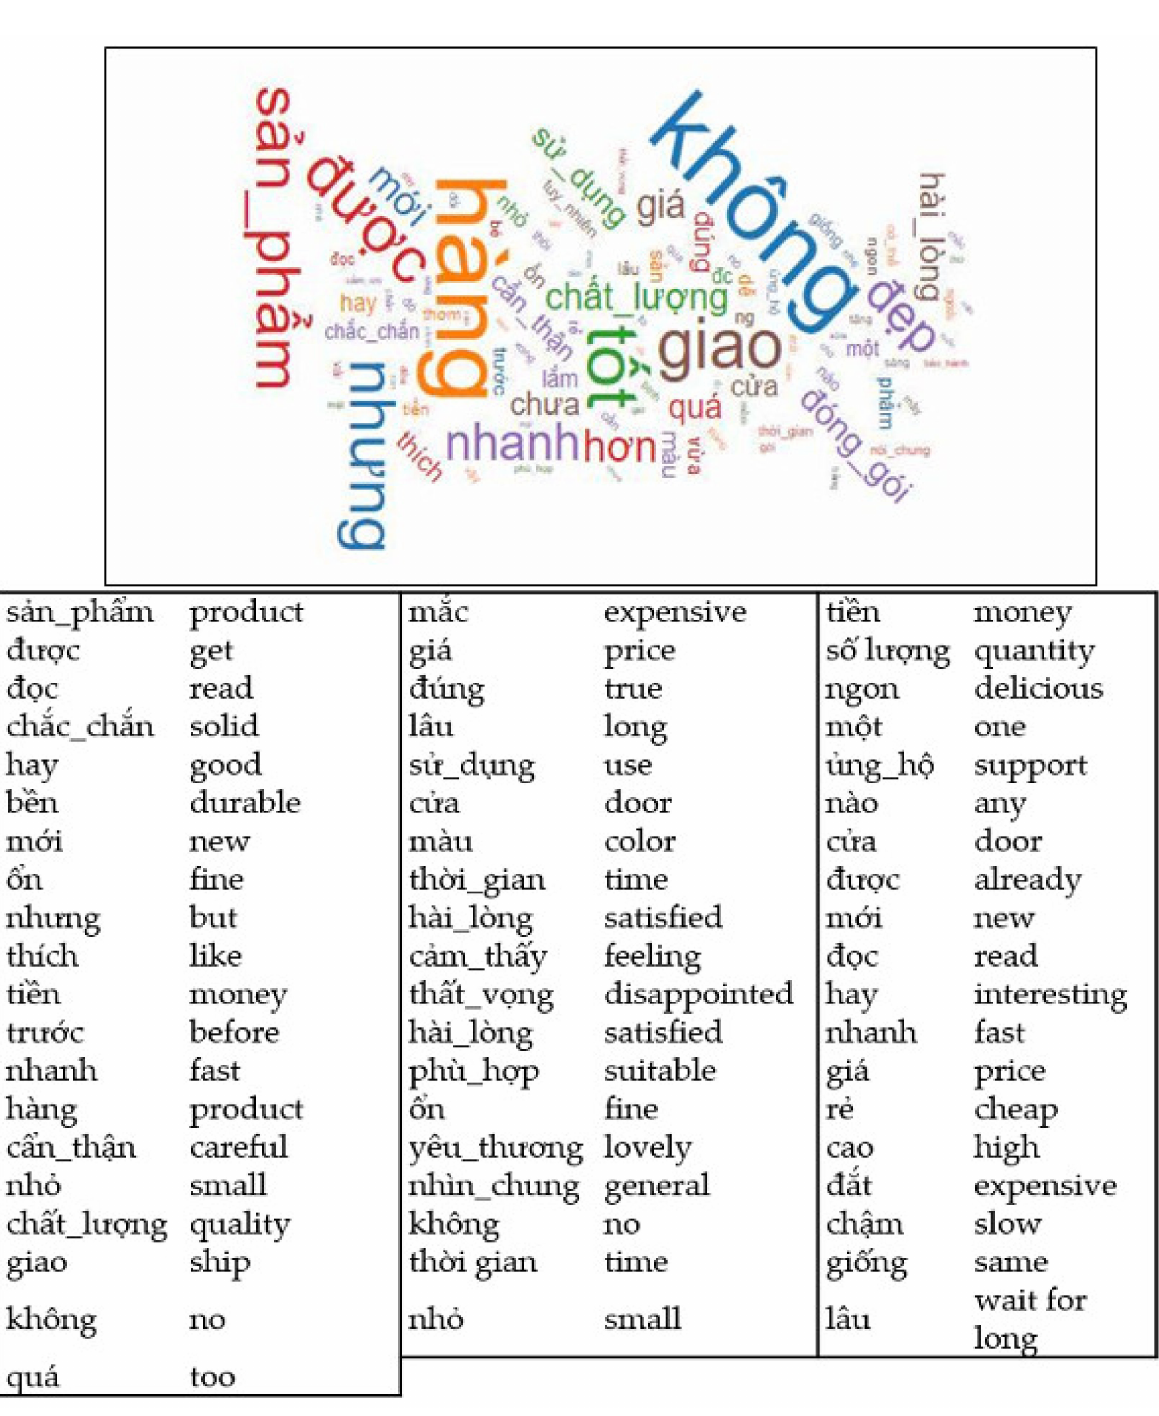
Figure 11. Word cloud for customer’s